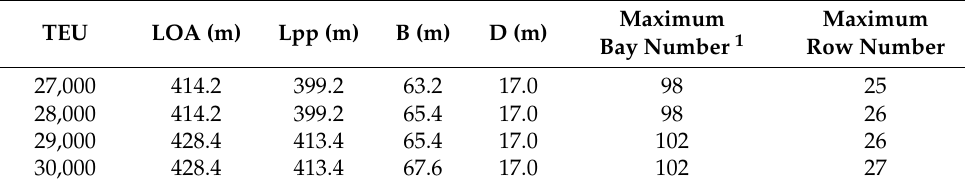
Table 11. Prediction results for mega-sized container